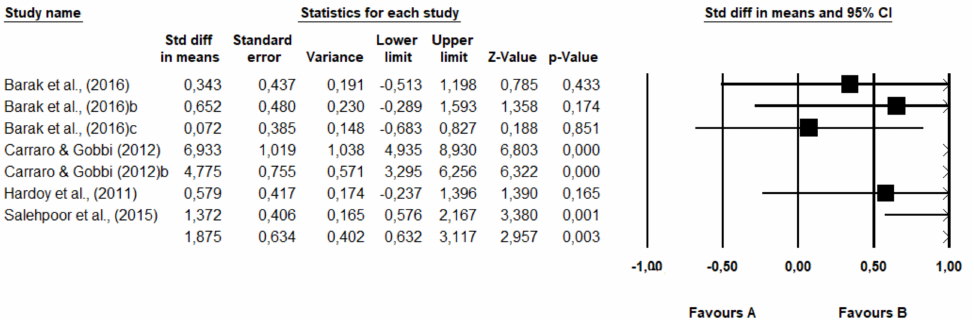
Figure 2. Summary of the descriptive and inferential statistics of the results of each study and the overall effect size of the effect on the anxiety symptoms in individuals with